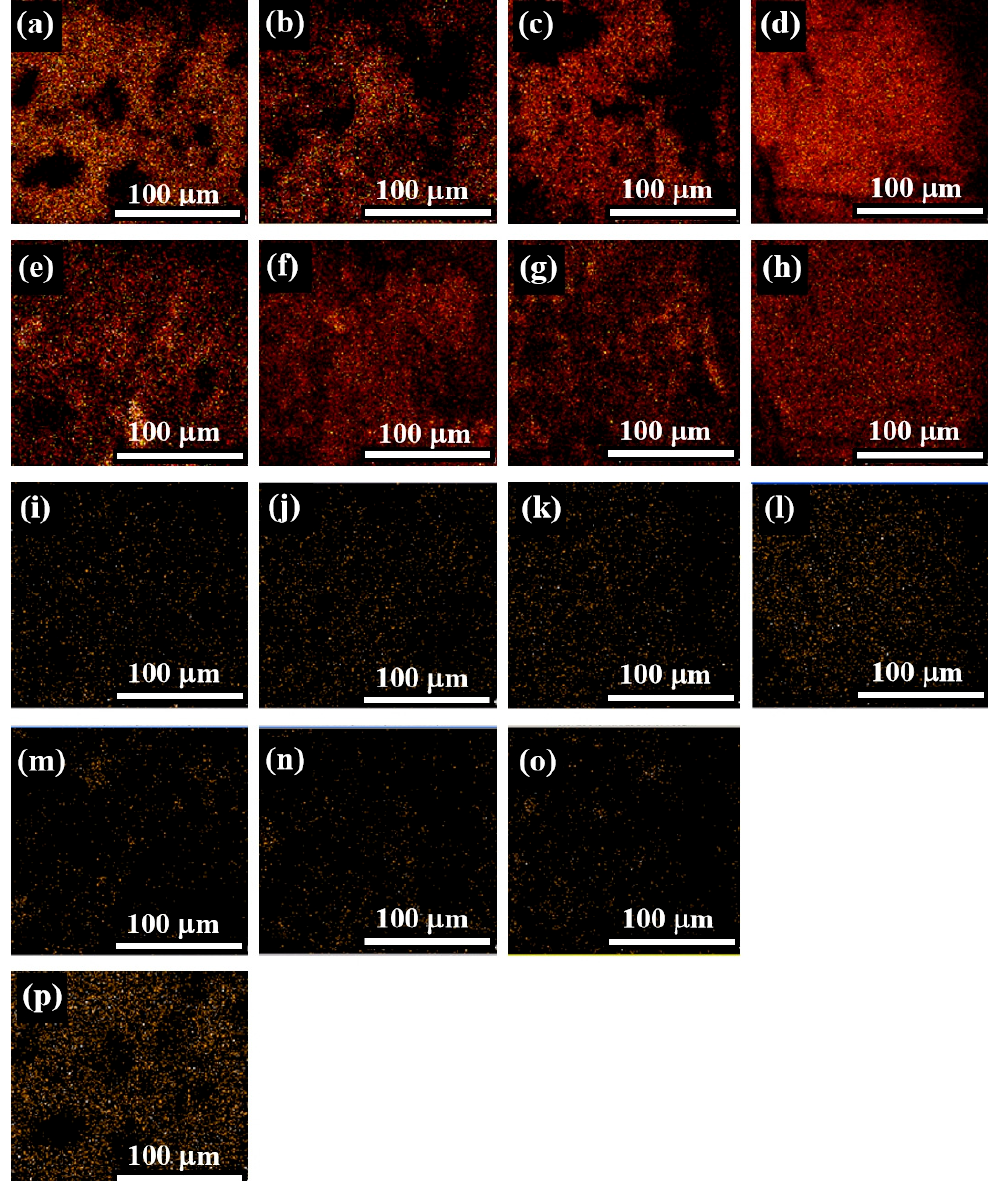
Figure 8. TOF-SIMS analysis results of the pigments’ glaze surface, showing secondary ion images of: